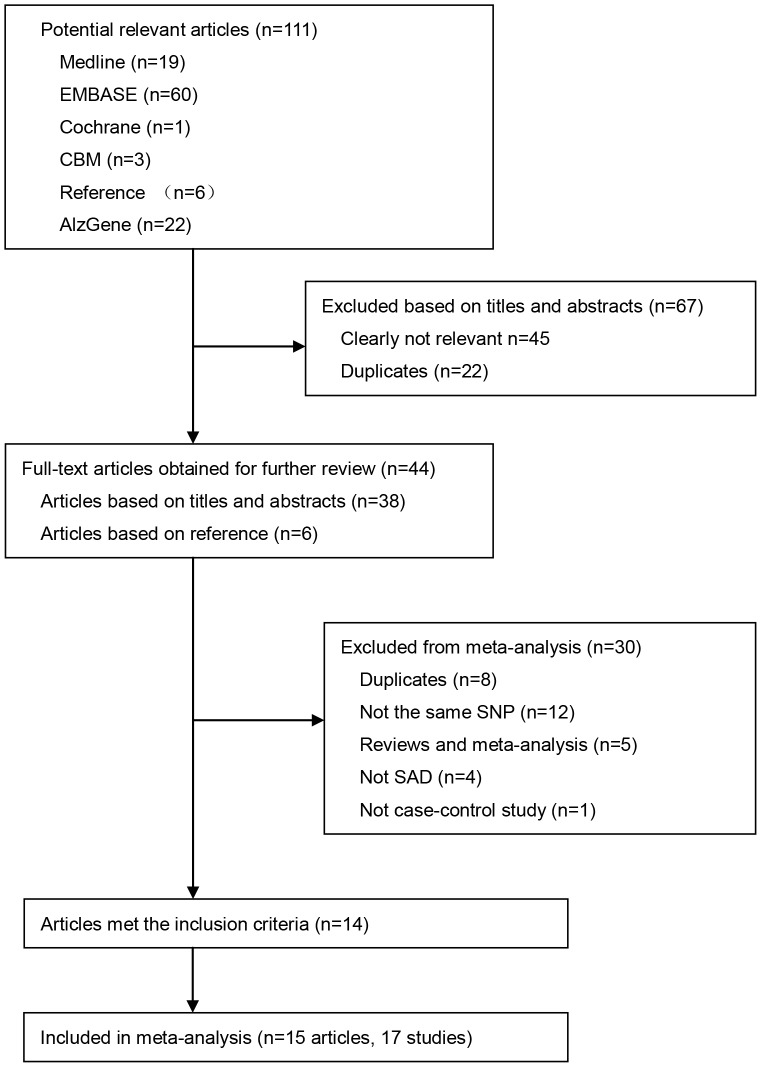
Flow diagram of study selection.A total of 15 articles, 14 published articles plus our study, were included in the meta-analysis. Of them, two published articles were regarded as two different studies as they included different subpopulations.